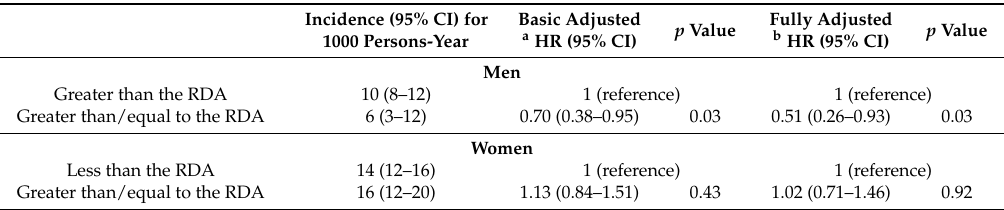
Table 2. Association between dietary magnesium intake and incidence of